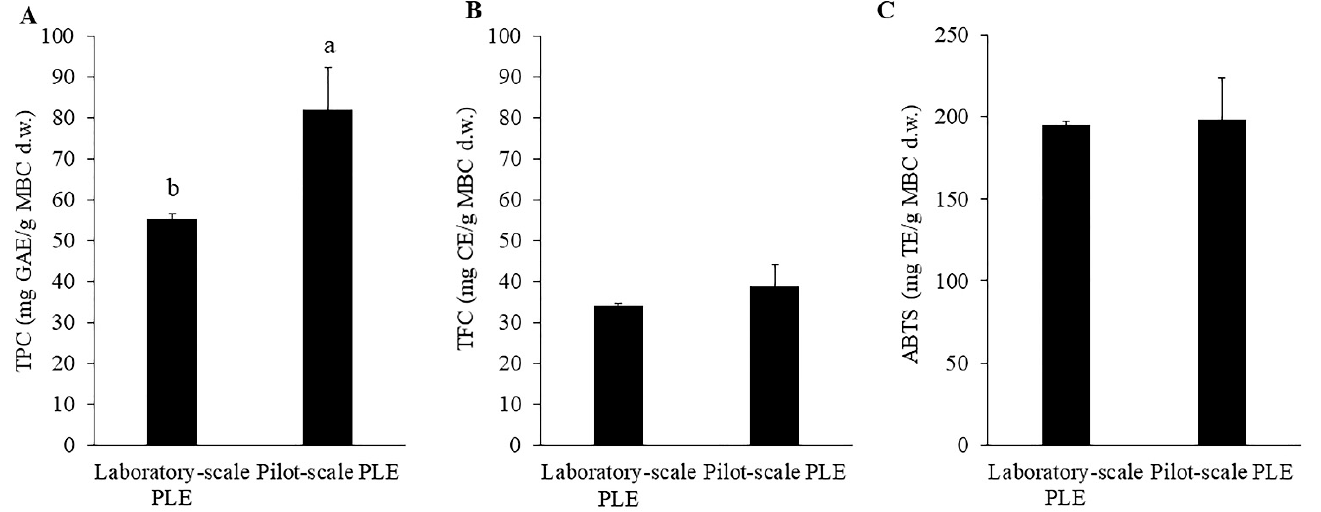
Figure 5. Total phenolic content ( A ), total flavonoid content ( B ) and ABTS ( C ) of MBC extract obtained by laboratory-scale PLE and pilot-scale PLE. There was no significant difference between laboratory-scale PLE and pilot-scale PLE. The different alphabet indicated significant difference at p < 0.05.